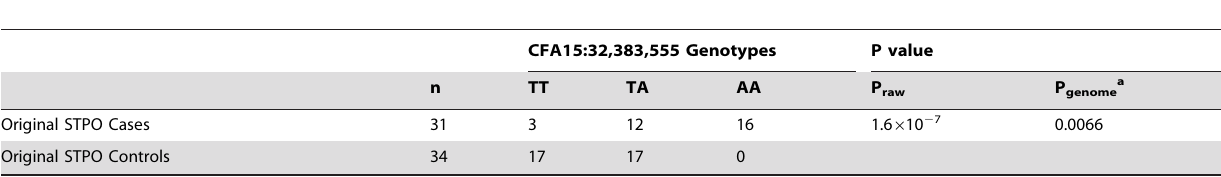
Table 1. Association between SCCD risk and the peak GWAS SNP, CFA15:32,383,555, in STPO cases and controls.